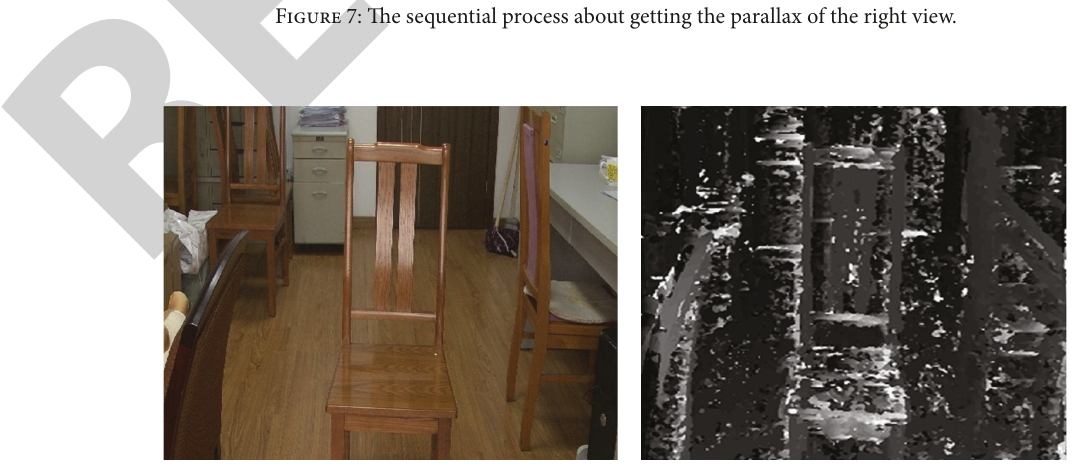
Figure 7: The sequential process about getting the parallax of the right view.